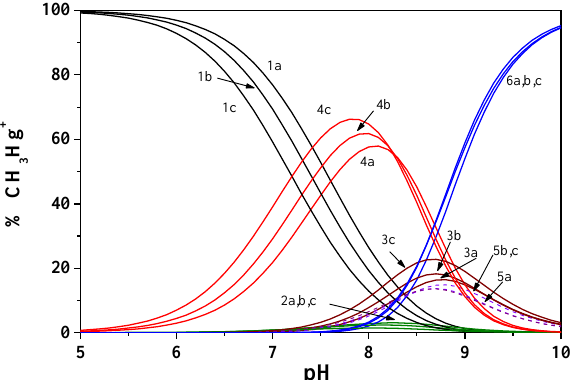
Figure 2. Distribution diagram for the CH 3 Hg + /Dop − species at T = 298.15 K and different ionic